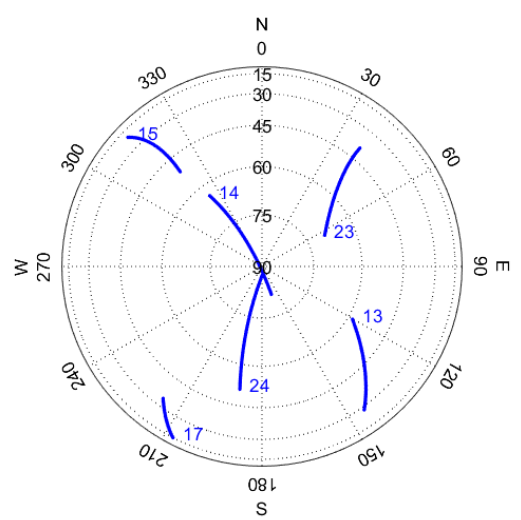
Figure 4. Observed Russia’s Global Navigation Satellite System (GLONASS) satellites shared by the two stations of baseline GOP6_GOP7 at GPST 9:00–10:00 a.m. on day of year (DOY) 180 of 2018. The satellite slot numbers in blue color are marked at the beginning of the satellite trajectories.